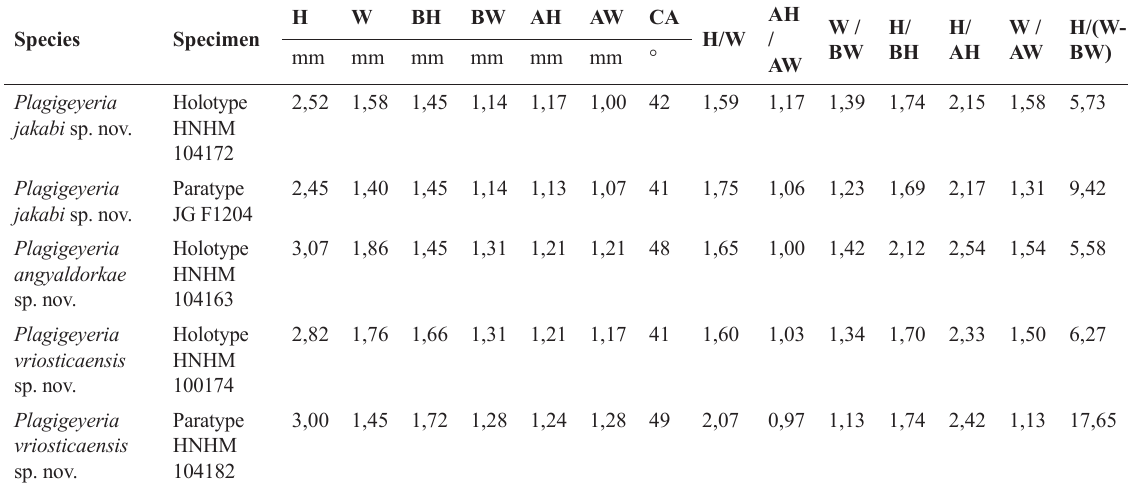
Table 3. Shell morphometry comparison of Plagigeyeria jakabi sp. nov., P. angyaldorkae sp. nov.